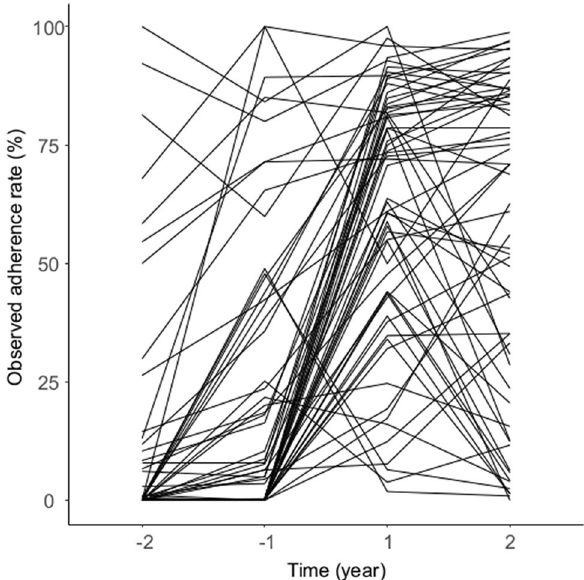
Figure 3. Data analysis frame for the primary (clinical pathway [CP] implementation effect) and secondary (CP application and/or completion effect)